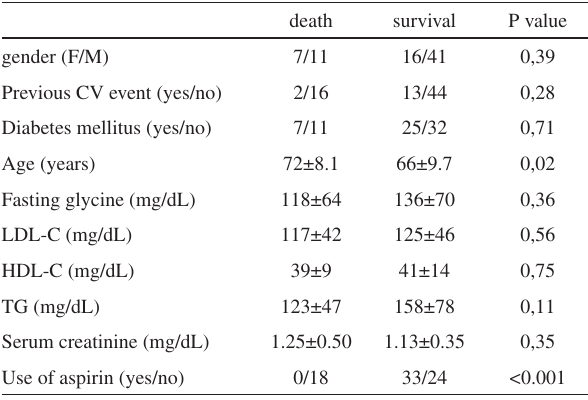
Table 1 - All-cause mortality and clinical variables